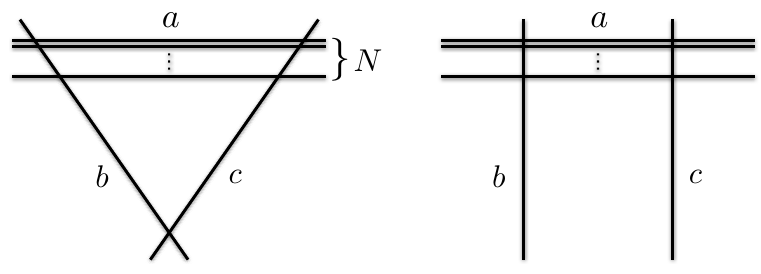
Figure 1 . Left: intersections of brane stack a with branes b and c , and brane b with c in the second torus T 2 ; right: intersections of brane stack a with branes b and c in torus T 2 2 c are parallel.